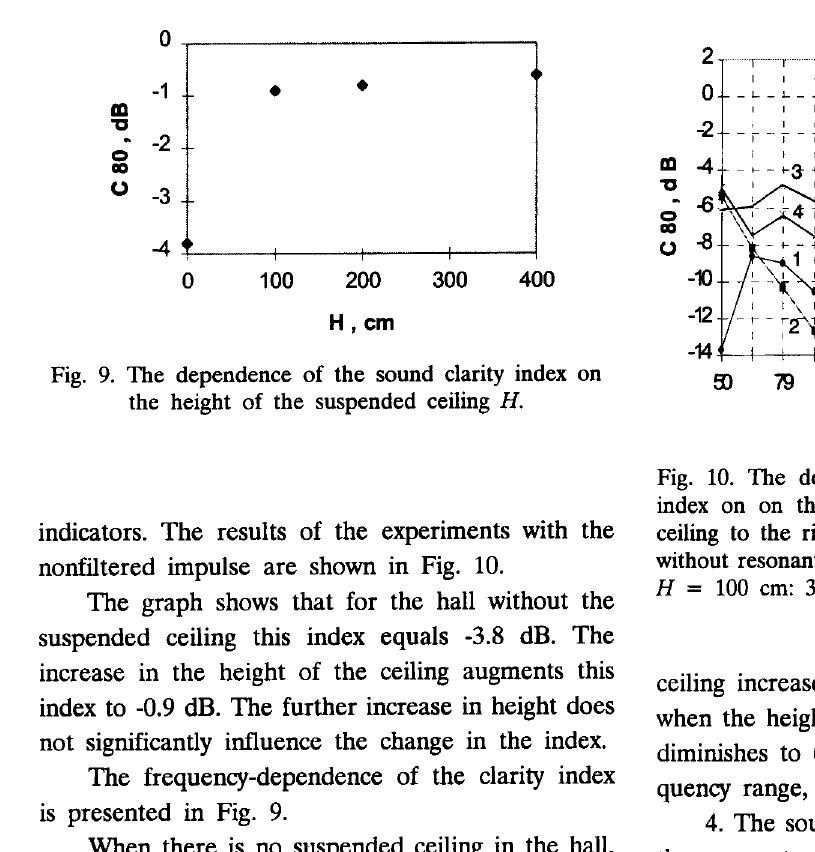
Fig. 9. The dependence of the sound clarity index on the height of the suspended ceiling H.